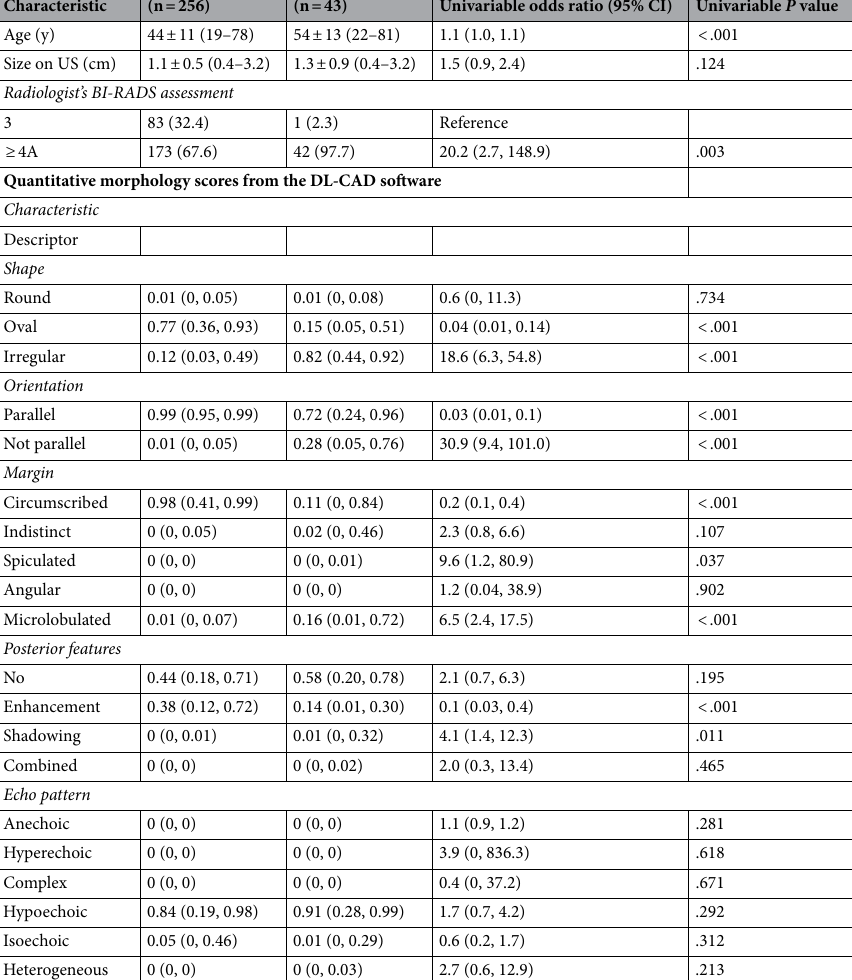
(97.7%, 42 of 43) had a final assessment of BI-RADS 4A or higher. In contrast, 67.6% (173 of 256) of the benign breast lesions had a final assessment of BI-RADS 4A or higher ( P = 0.003). With regard to the differences in the quantitative morphologic scores obtained from the DL-CAD software between the benign and malignant breast lesions, the malignant breast lesions had a lower oval shape score (median, 0.15 vs. 0.77, P < 0.001), higher irreg- ular shape score (0.82 vs. 0.12, P < 0.001), lower parallel orientation score (0.72 vs. 0.99, P < 0.001), higher non- parallel orientation score (0.28 vs. 0.01, P < 0.001), lower circumscribed margin score (0.11 vs. 0.98, P < 0.001), higher spiculated margin score (0 [interquartile ranges, 0–0.01] vs. 0 [0–0], P = 0.037), higher microlobulated margin score (0.16 vs. 0.01, P < 0.001), lower posterior enhancement score (0.14 vs. 0.38, P < 0.001), and higher posterior shadowing score (0.01 vs. 0, P = 0.011), compared with the benign breast lesions. In the multivari- able analysis, four variables were independently associated with malignancy (Table 3): BI-RADS 4A or higher (odds ratio [OR], 14.7 [95% confidence interval (CI) 1.7, 125.6], P = 0.014), older age (OR, 1.1 [95% CI 1.0, 1.1], P < 0.001), higher irregular shape score (OR, 5.1 [95% CI 1.3, 19.4], P = 0.018), and lower parallel orientation score (OR, 0.1 [95% CI 0, 0.6], P = 0.007) obtained from the DL-CAD software. Development and validation of a nomogram. A diagnostic model incorporating the four aforemen- tioned variables was developed and presented as a nomogram (Fig. 1a). In the development cohort, the AUC of the radiologists’ BI-RADS final assessment was 0.65 (95% CI 0.61, 0.69), whereas the AUC in the case of the diagnostic model was 0.89 (95% CI 0.84, 0.93) (Fig. 1b). The bootstrap-corrected AUC of the diagnostic model